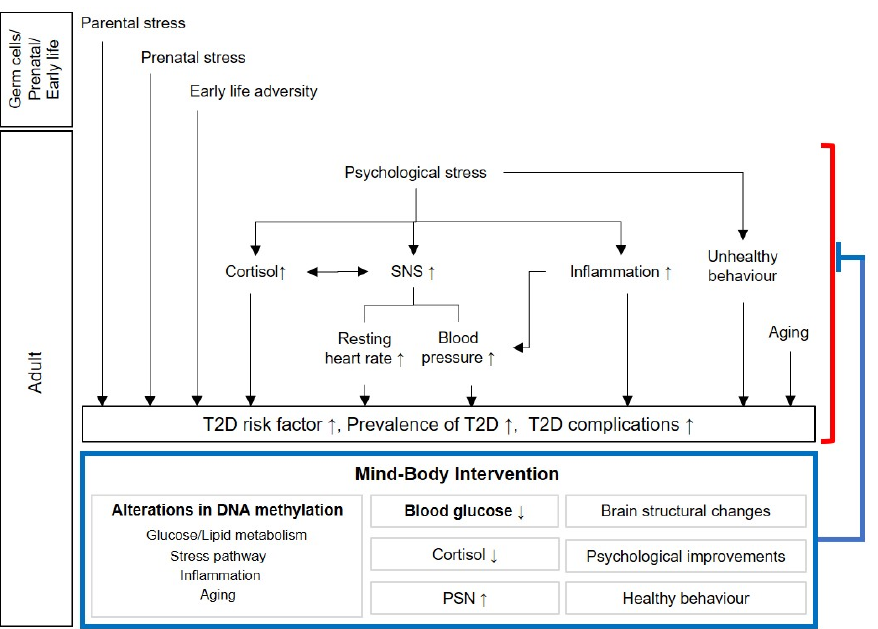
Figure 1. Potential causes contributing to type 2 diabetes (red) and mind–body intervention-induced beneficial changes including altered epigenetic modification (blue). Abbreviations: SNS, sympathetic nervous system; T2D, type 2 diabetes; PSN, parasympathetic nervous system; ↑ , increased; ↓ , reduced.